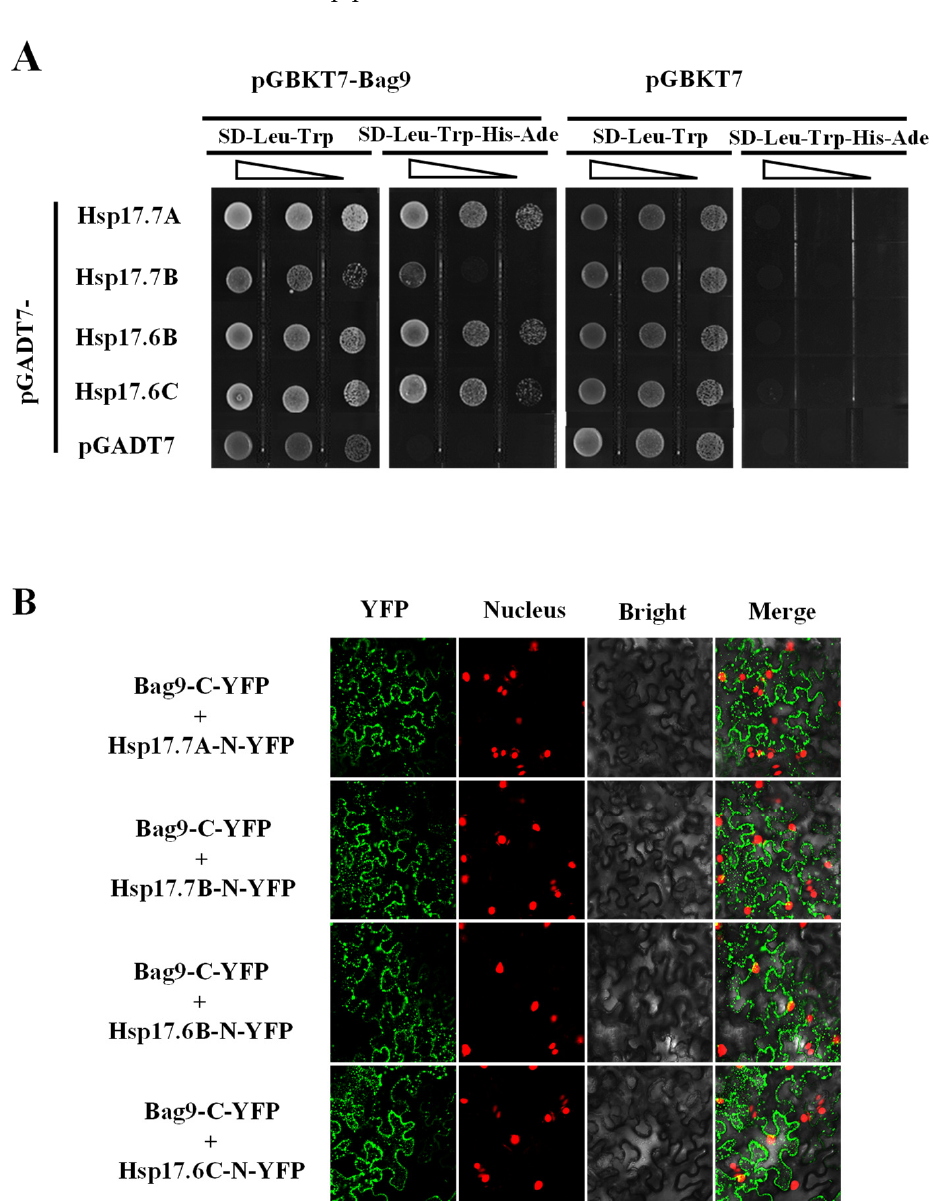
Figure 7. BAG9 interacted with Hsp20s. ( A ) Yeast two-hybrid assay showed interactions between BAG9 and Hsp17.7A, Hsp17.7B, Hsp17.6B, and Hsp17.6C. By growing yeast cells at different concen- trations lacking Trp (T), Leu (L), Ade (A), and His (H), the interaction of proteins has been